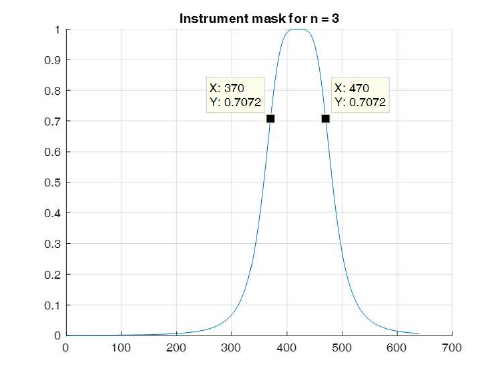
Figure 12. Section of single instrument’s mask for n = 3, r = 50.